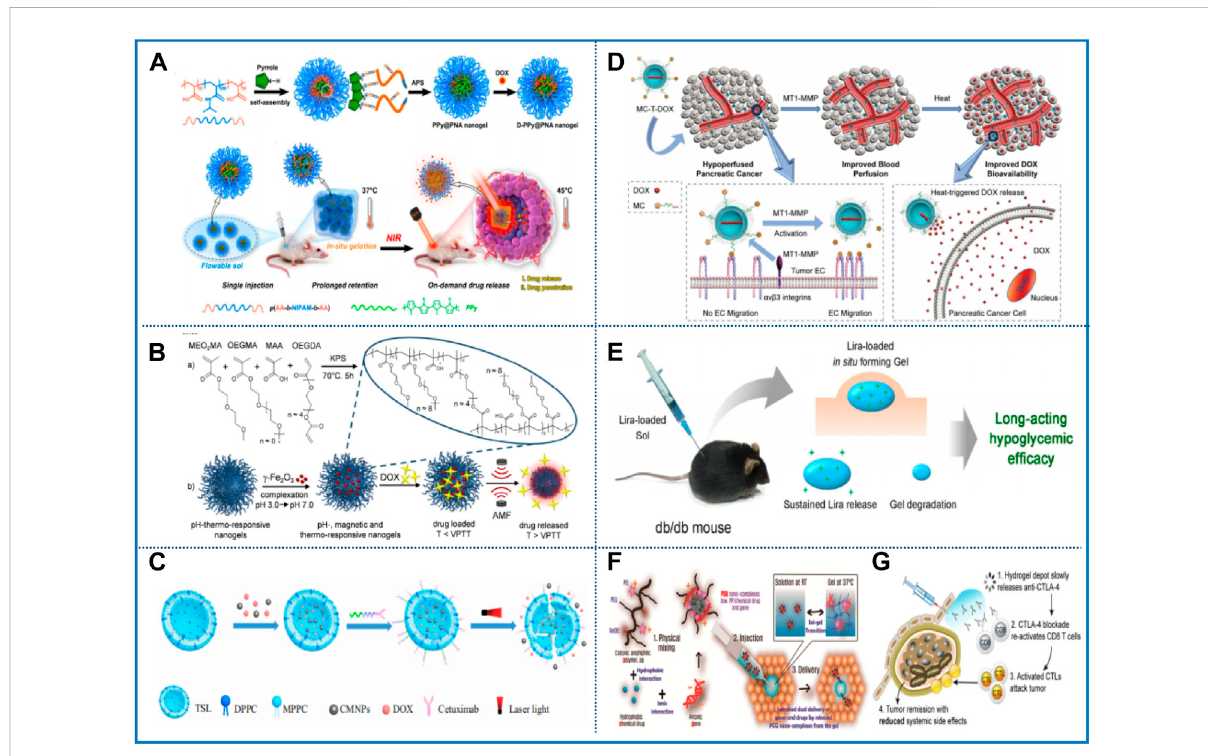
FIGURE 6 Representative studies ofthermosensitive nanomaterialsin drug delivery. (A) Schematic illustrationof thepreparationofD-PPy@PNA nanogels and D-PPy@PNA nanogels based in situ forming hydrogels for synergisticphotothermal-chemotherapy. Reprinted with permission from Geng et al. (2020). Copyright © 2020 American Chemical Society. (B) Illustration of MagNanoGels synthesis and remotely controlled drug delivery under AMF. Reprinted with permission from Cazares-Cortes et al. (2017). Copyright © 2017 American Chemical Society. (C) Schematic illustration of NIR- triggered DOX release from CET-DOX-CMNP-TSLs. Reprinted with permission from Dorjsuren et al. (2020). Copyright © 2020 International Journal of Nanomedicine. (D) Mode of action by which MC-T-DOX effectively and speci fi cally improves tumor blood perfusion and drug delivery in pancreatic cancer. Reprinted with permission from Wei et al. (2020b). Copyright © 2020 Advance Science. (E) Schematic illustration of the long- acting antidiabetic formulation using injectable hydrogel. Reprinted with permission from Chen et al. (2016). Copyright © 2016 American Chemical Society. (F) Injectable ternary nanocomplex hydrogel for long-term chemical drug/gene dual delivery. Reprinted with permission from Kim et